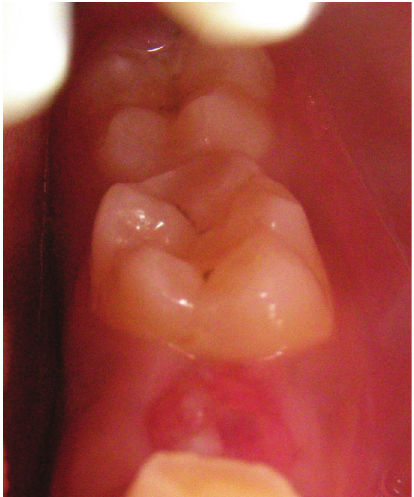
Figure 1: A nontender, persistent swelling in the region of lower left posterior region.